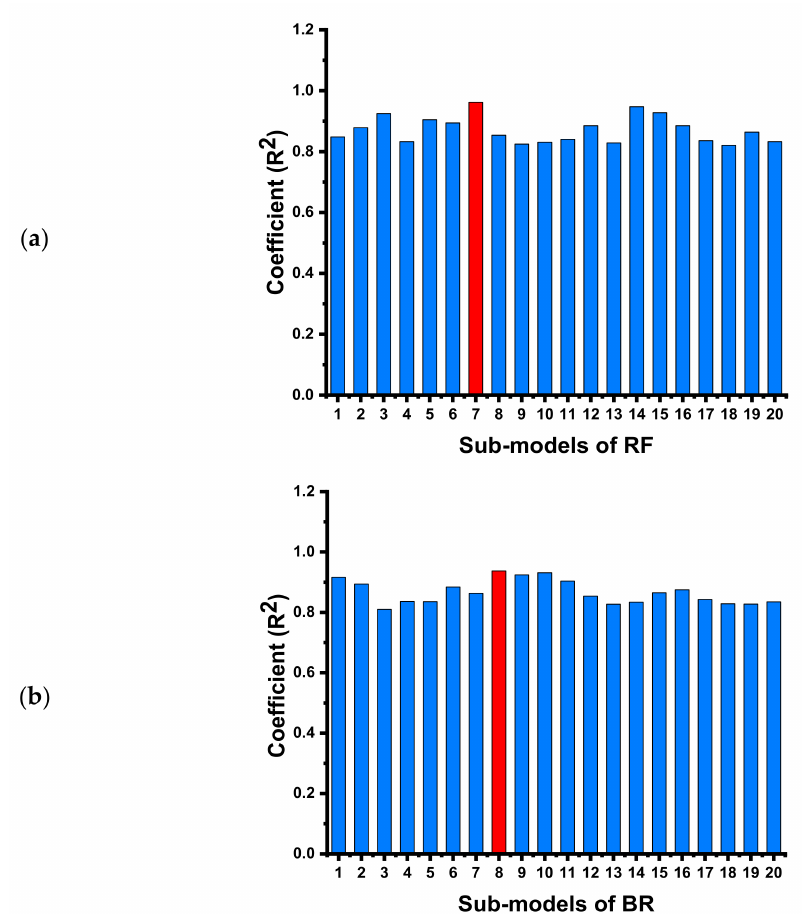
Figure 17. Coefficient of determination result of the 20 sub-models for; ( a ) RF, ( b ) BR